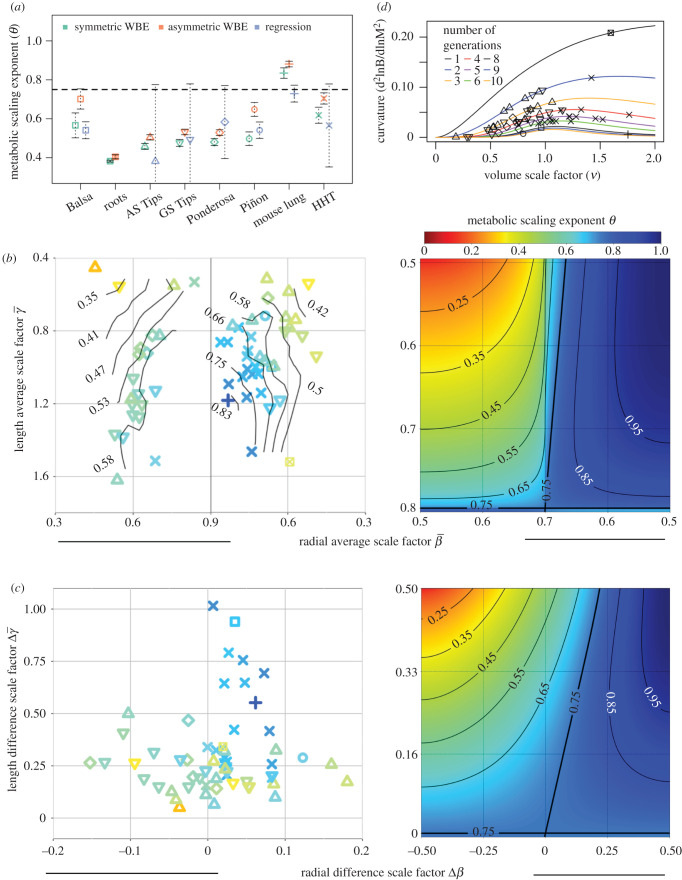
Variation in metabolic scaling exponents related to variation in branching geometry. (a) Comparison of symmetric (red) and asymmetric (green) estimates of metabolic scaling exponents to regression (blue) based estimates. For groups with multiple species and/or multiple individuals (AS Tips, GS Tips, Ponderosa and HHT), metabolic scaling exponents were calculated at the species/individual level when averaged. Error bars represent 95% confidence intervals. The horizontal dashed line represents a metabolic scaling exponent value of 3/4. Note that (a) also serves as a legend for the symbols in all other subfigures. (b) Empirically based estimates of metabolic scaling exponents are presented as functions of the geometrically averaged length and radial average scale factor values (left), and compared to theoretical predictions (right) reproduced from Brummer et al. [28]. (c) Analogous results are presented as in (b) but instead for the length and radius difference scale factors. Solid black lines represent contours of constant metabolic scaling exponent values. Axis ranges differ between empirical data and theory-based predictions due to observed deviations from conservation equations. (d) Curvature of metabolic rate versus mass (log–log) as a function of volume scaling (νASYM) and the number of branching generations (N).